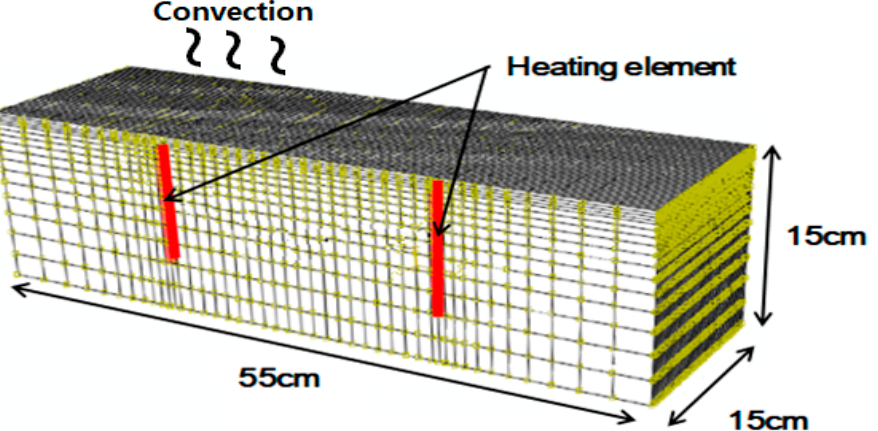
Figure 7. Element mesh and boundary conditions used for the simulations (laboratory tests).